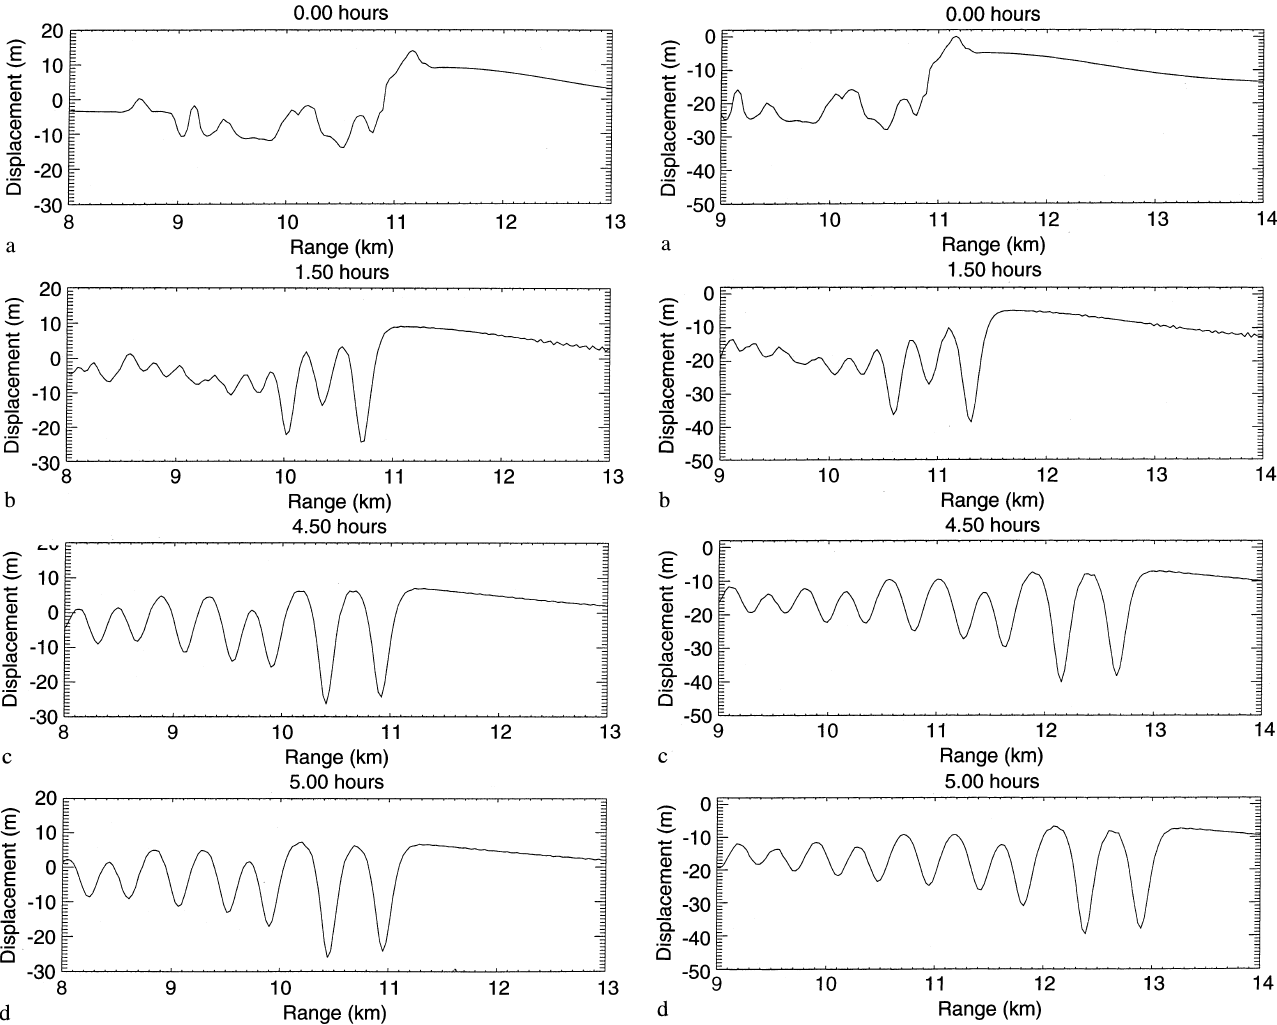
Fig. 14a–d. KdV model results for experiment 1, showing the displacement g . a Initial waveform, from the first survey; b model run after 1.5 h; c after 4.5 h, and d after 5 h. Range axis is ( x ) c with an arbitrary origin